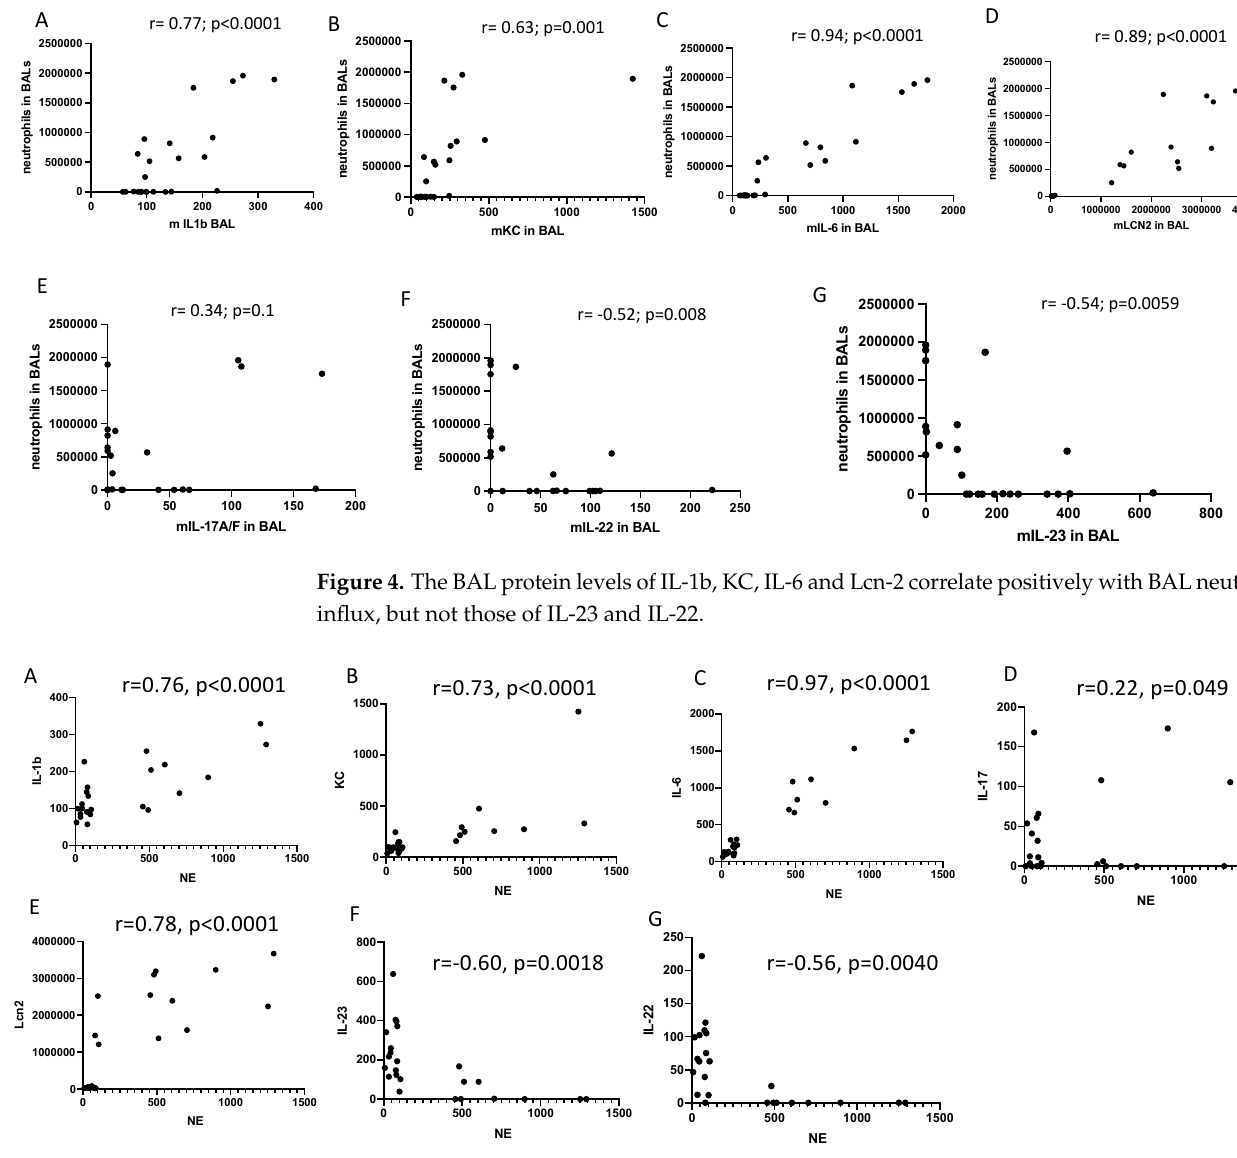
Figure 5. The BAL protein levels of IL-1b, KC, IL-6 and Lcn-2 correlate positively with neutrophil elastase activity, but not those of IL-23 and IL-22.